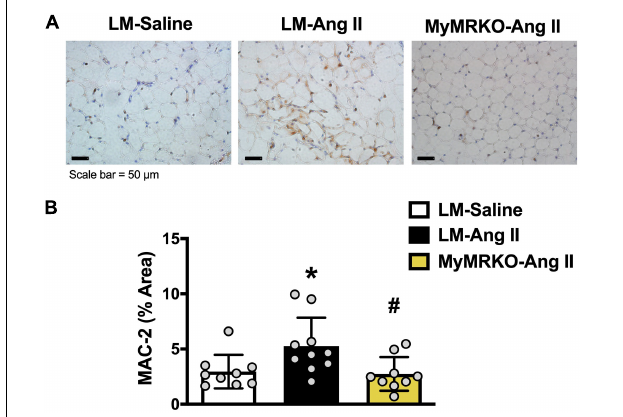
FIGURE 4 | Macrophage infiltration in visceral adipose tissue is decreased in MyMRKO mice. Representative image of Mac-2 staining in visceral adipose tissue (VAT) of the different cohorts (A) ; Mac-2 staining quantification (B) . * p ≤ 0.05 LM-Ang II vs. LM-Saline; # p ≤ 0.05 LM-Ang II vs. MyMRKO-Ang II. n = 9–10 for all groups. LM, littermate; Ang II, angiotensin II; MyMRKO, myeloid mineralocorticoid receptor knockout.